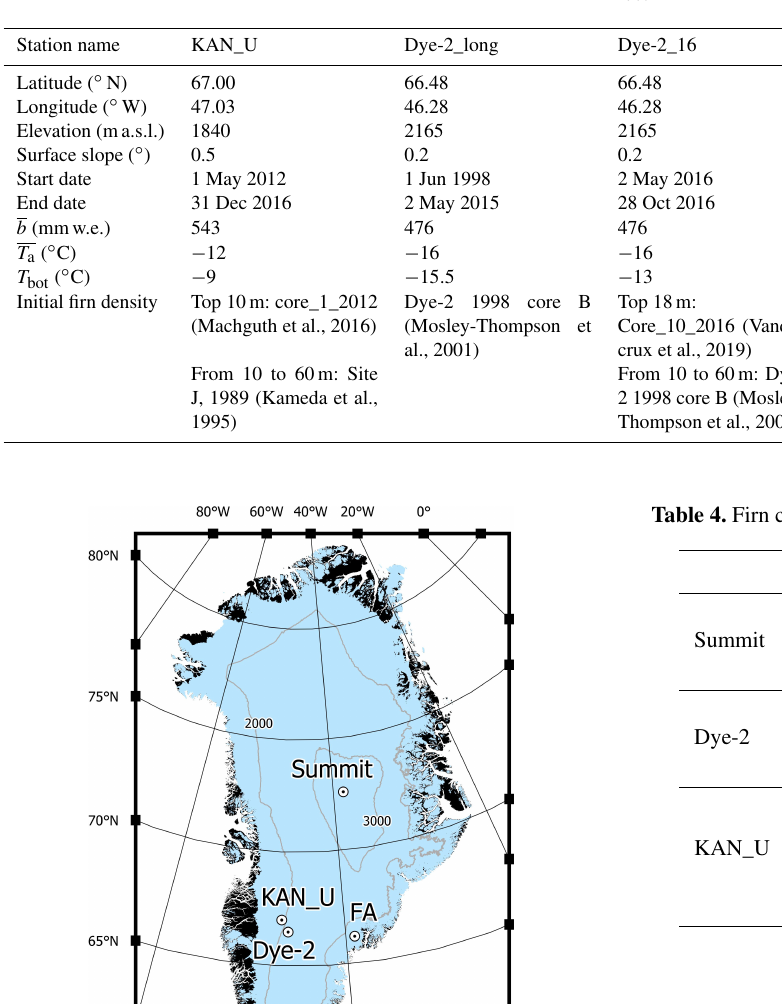
Table 3. Information about the four sites and five model runs considered in the comparison, including mean annual accumulation ( b ), mean annual air temperature ( T a ) and prescribed bottom firn temperature ( T bot ).